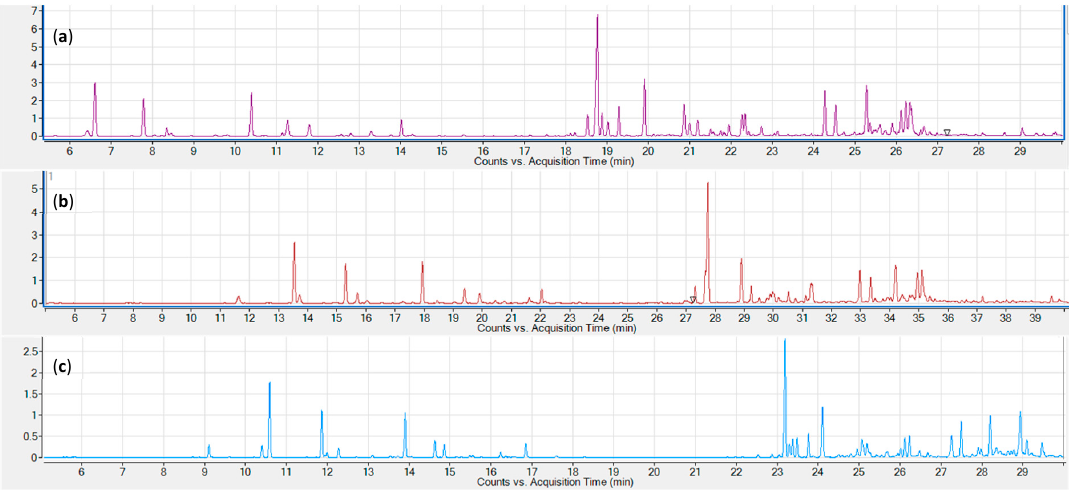
Figure 1. Comparison of three cannabis volatile sampling techniques. ( a ) static headspace; ( b ) solid-phase microextraction (SPME); ( c ) liquid extract (Hexane).